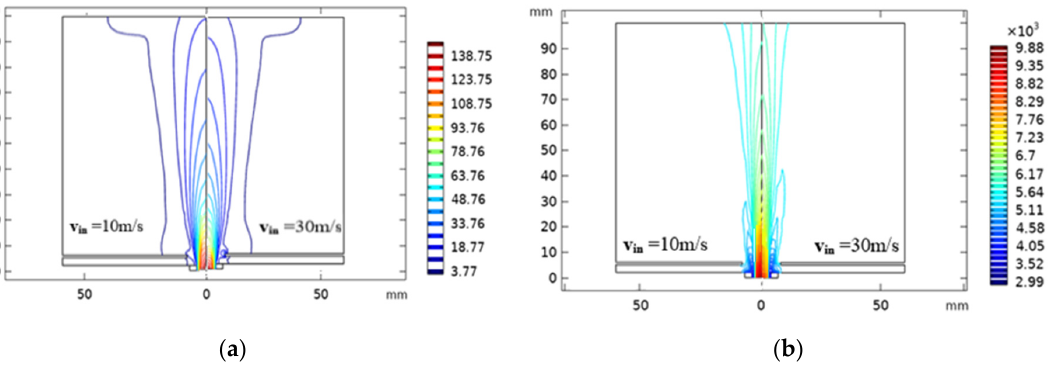
Figure 9. ( a ) Velocity field distribution and ( b ) computed isotherms of the turbulent plasma jet with swirl flow for different injection particles velocities (v in = 10 m/s and v in = 30 m/s).